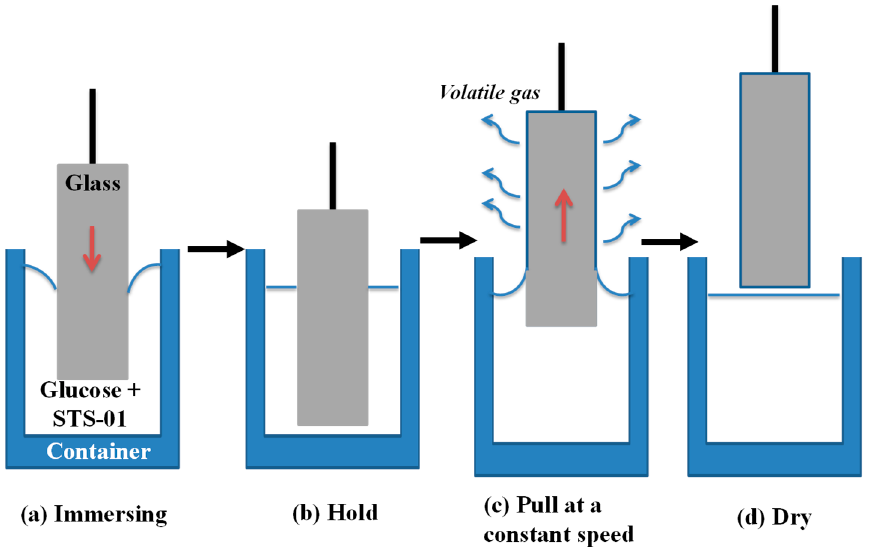
Figure 13. Schematic drawing of impregnation process, including ( a ) immersing in the reaction solution (glucose + STS-01); ( b ) hold for 10 min; ( c ) pull at a constant speed; ( d ) dry in ambient air.